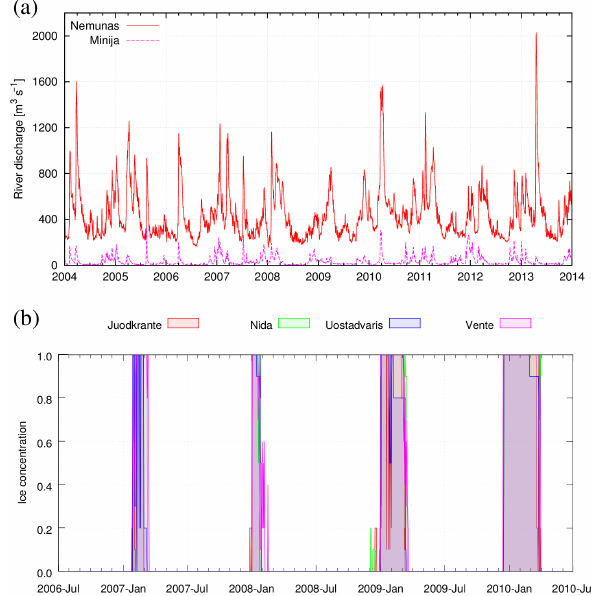
Figure 2. River discharge from 2004 to 2014 into the Curonian Lagoon (a) and measured ice concentration in the years 2007– 2010 (b) . In the discharge panel only Nemunas and Minija are shown. The contribution of all other rivers is less than 5%. The ice data show that the freezing and melting happens very fast (on the order of